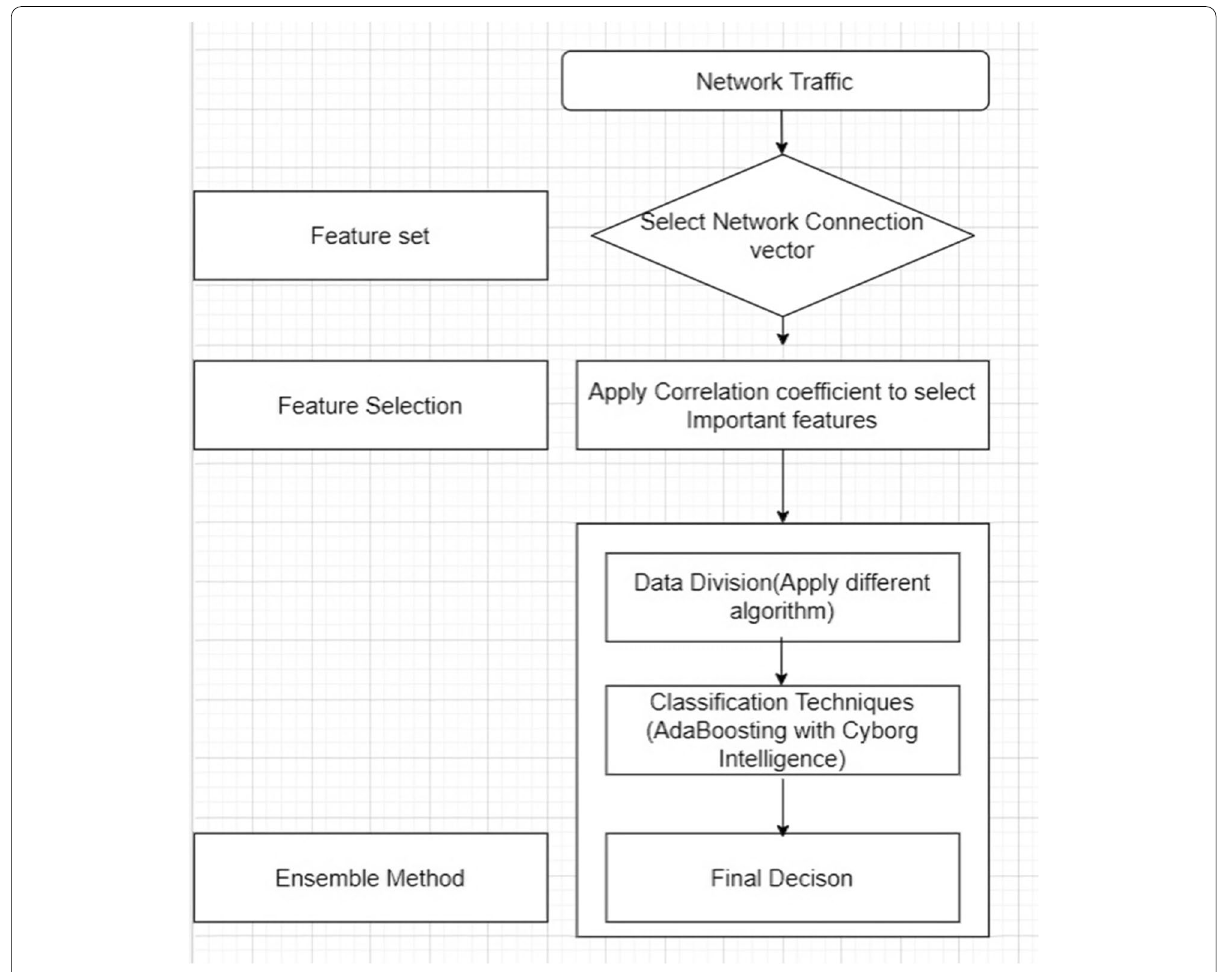
Fig. 10 Flowchart of AdaBoost